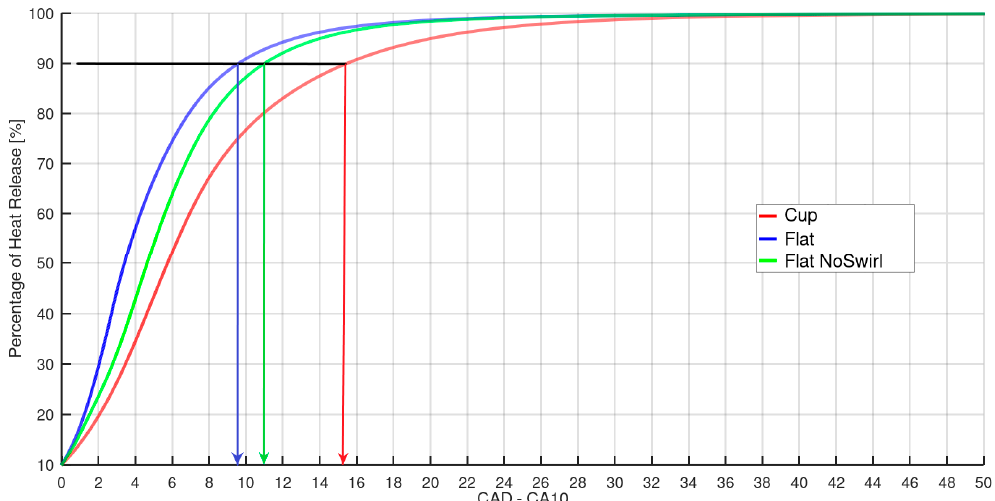
Figure 18. Percentage of total heat release for the three cases. The value on the x-axis identified by the arrows represents the combustion duration.